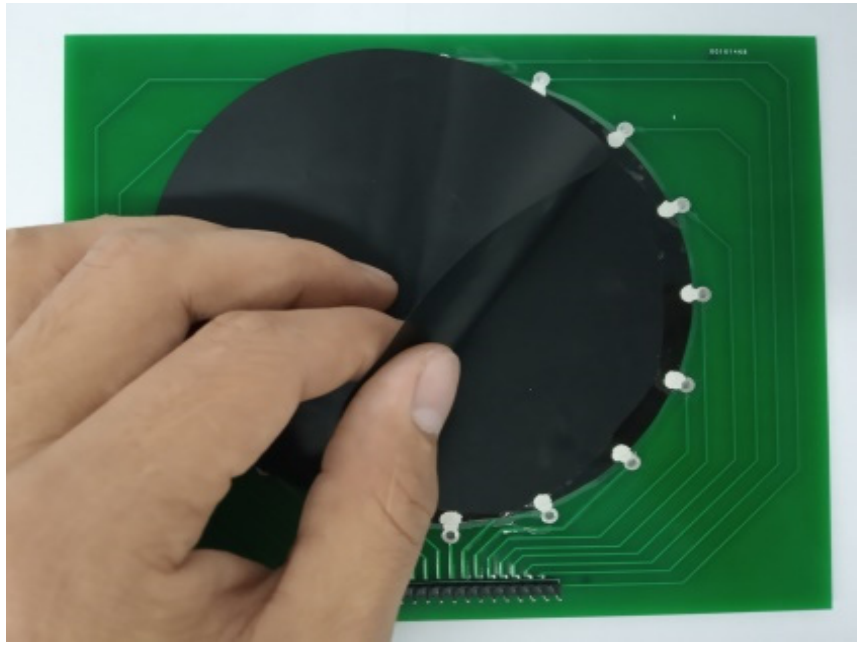
Figure 4. Two-layer structural sensor.